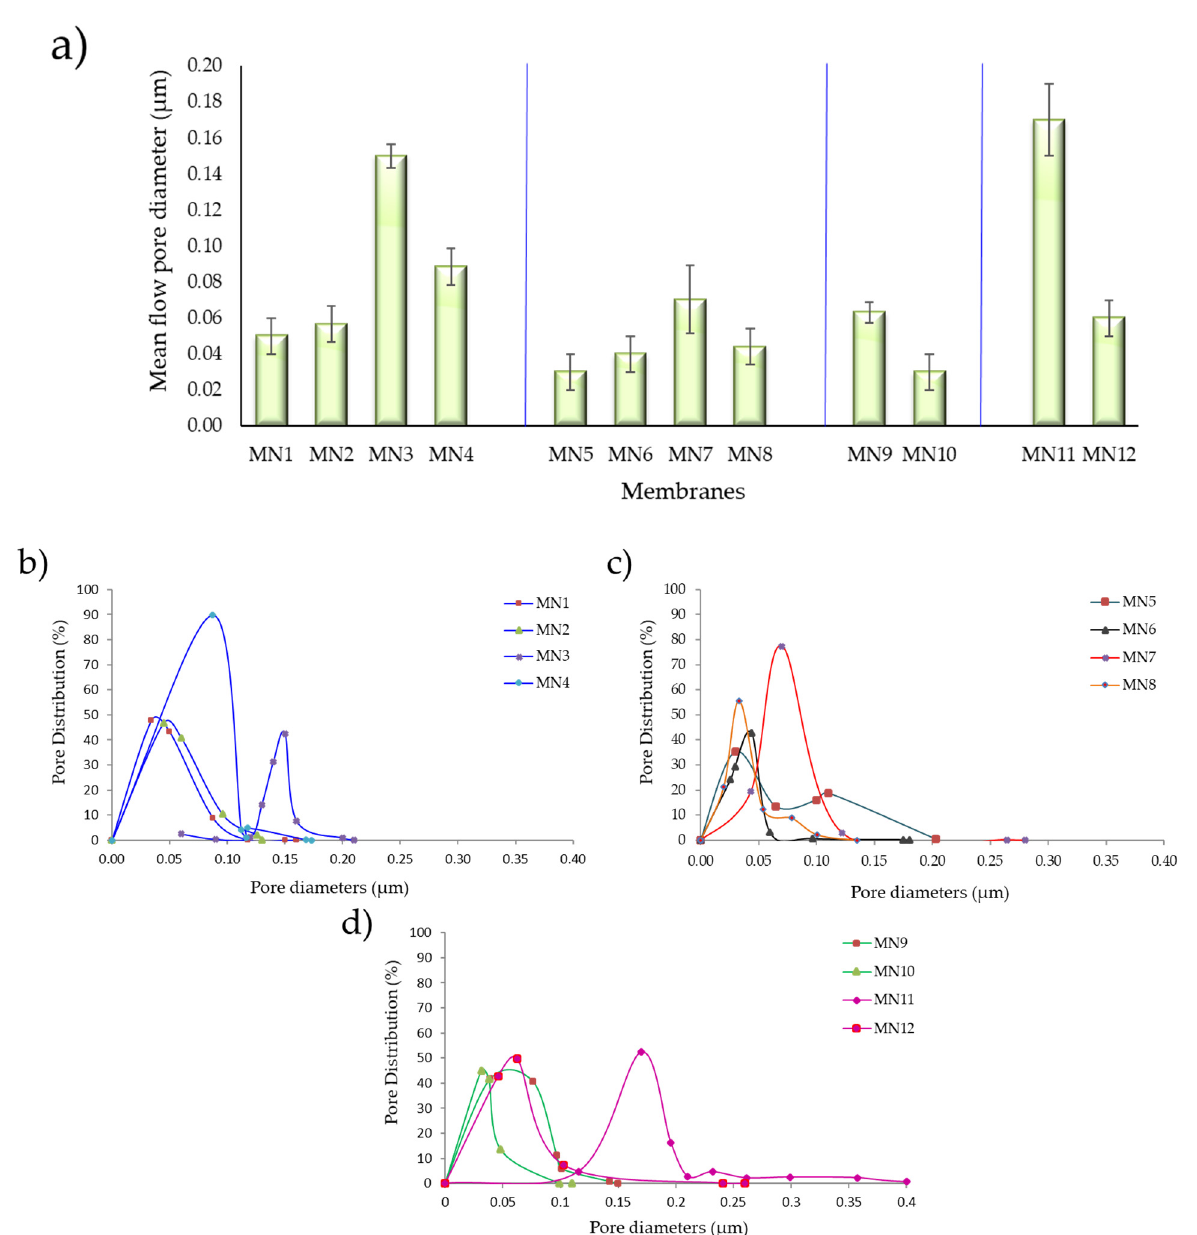
Figure 6. ( a ) Mean flow pore diameter and ( b – d ) pore size distribution of investigated membranes.